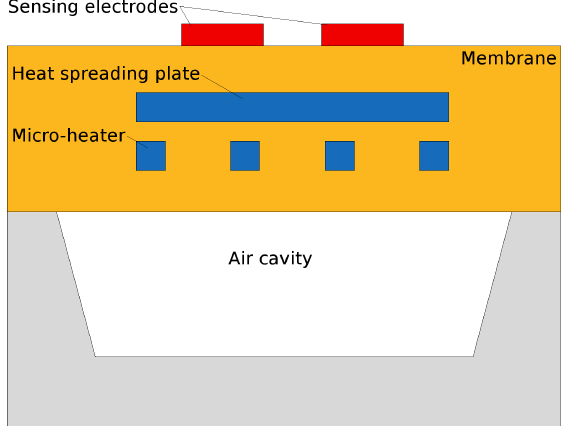
Figure 6. Schematic of the layers composing the membrane of the